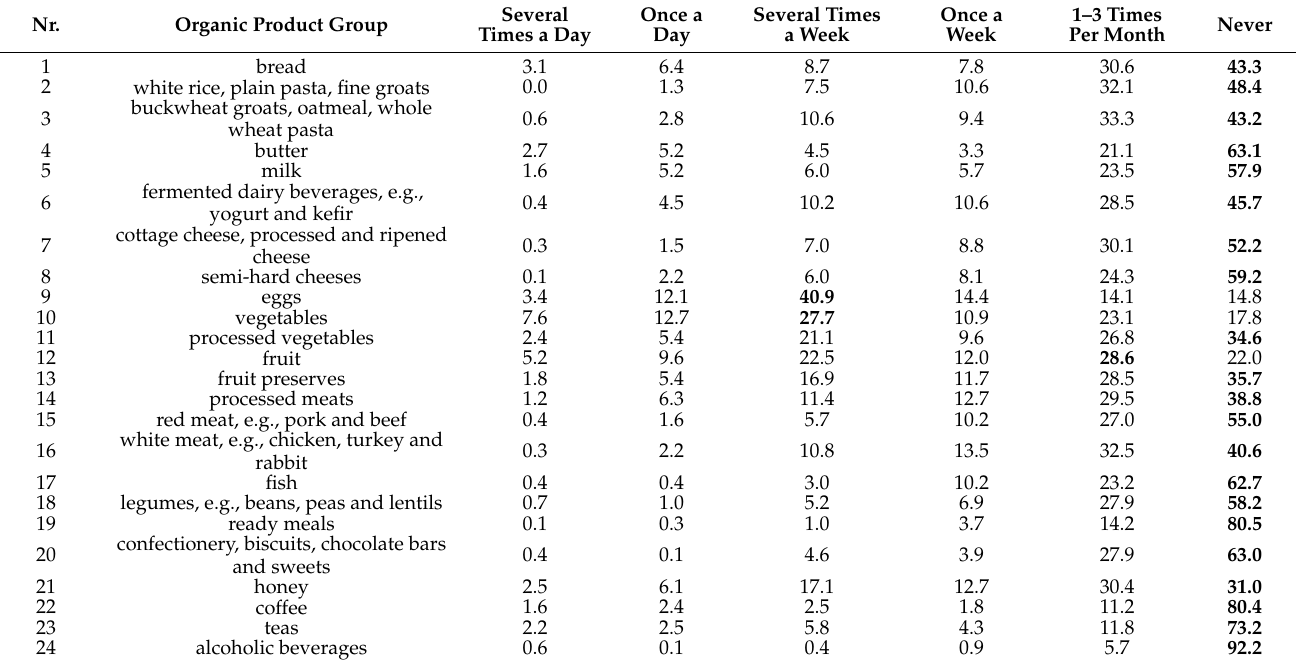
bold values highlight the consumption frequencies indicated by the highest proportion of female